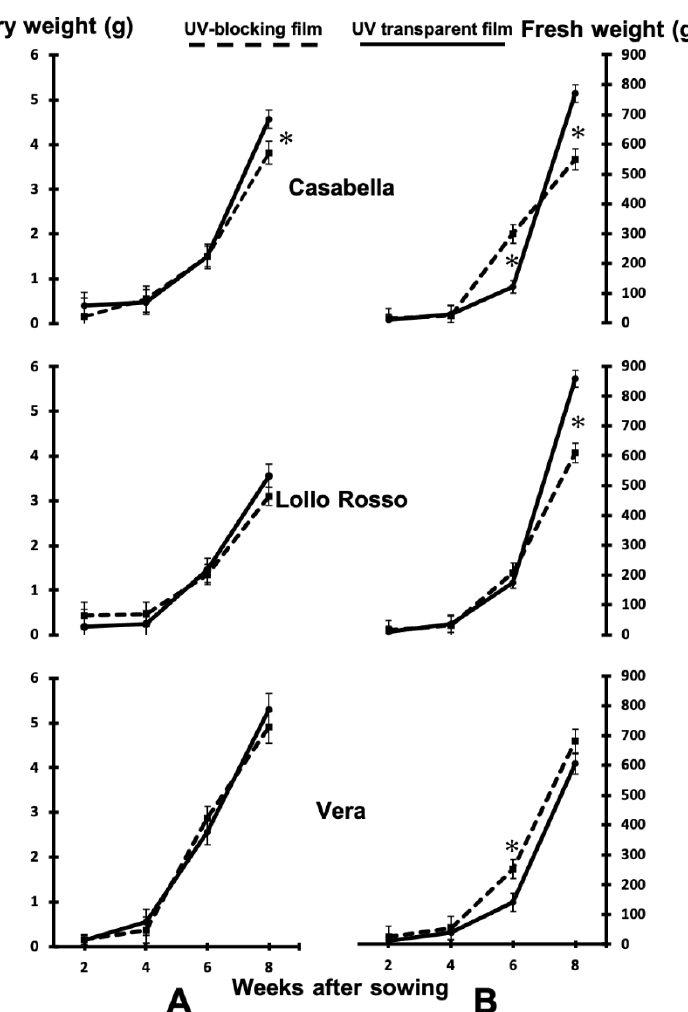
Figure 4. Effects of plastic sheeting on dry ( A ) and fresh weight ( B ) in three cultivars of lettuce. Vertical bars show SE ( n = 18). * indicates significant differences within each cultivar between UV-transparent and UV-blocking films according to LSD test at p < 0.05. No symbol indicates no differences .